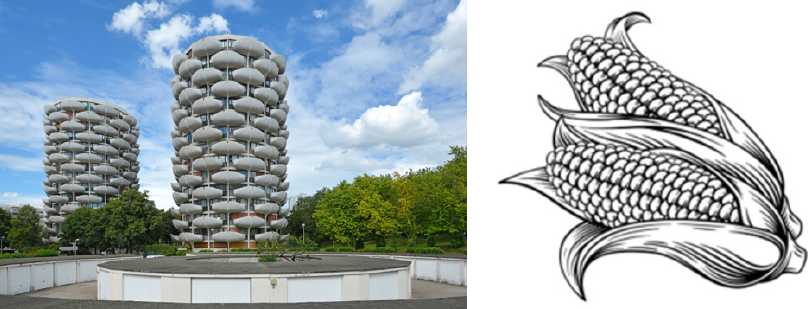
Figure 6. Choux de Créteil housing project [48] evokes botanical images.